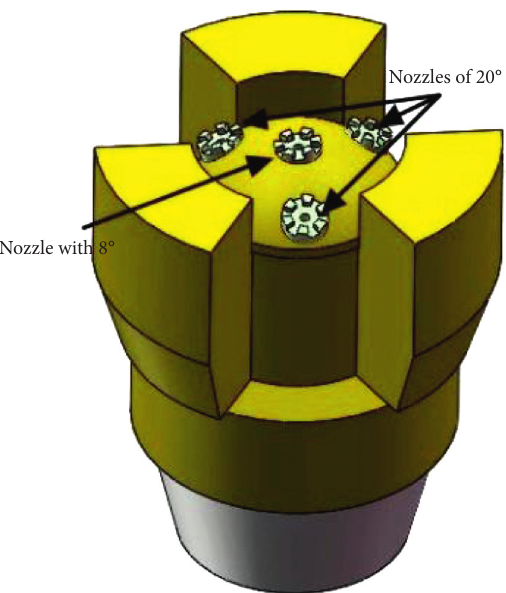
Figure 11: The nozzle layout.